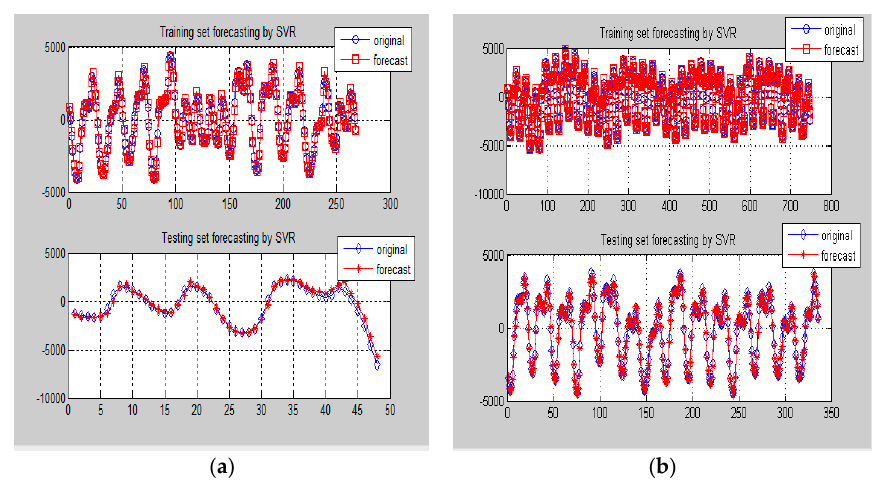
Figure 10. The decomposed different items for the small data size (Example 2). ( a ) IMF (intrinsic